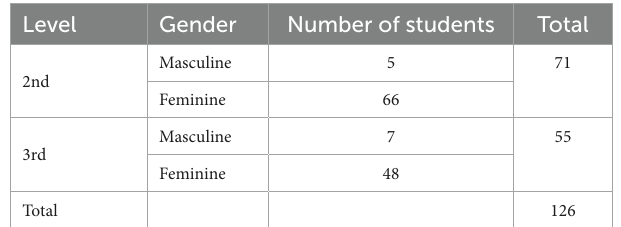
TABLE 1 Participants in the